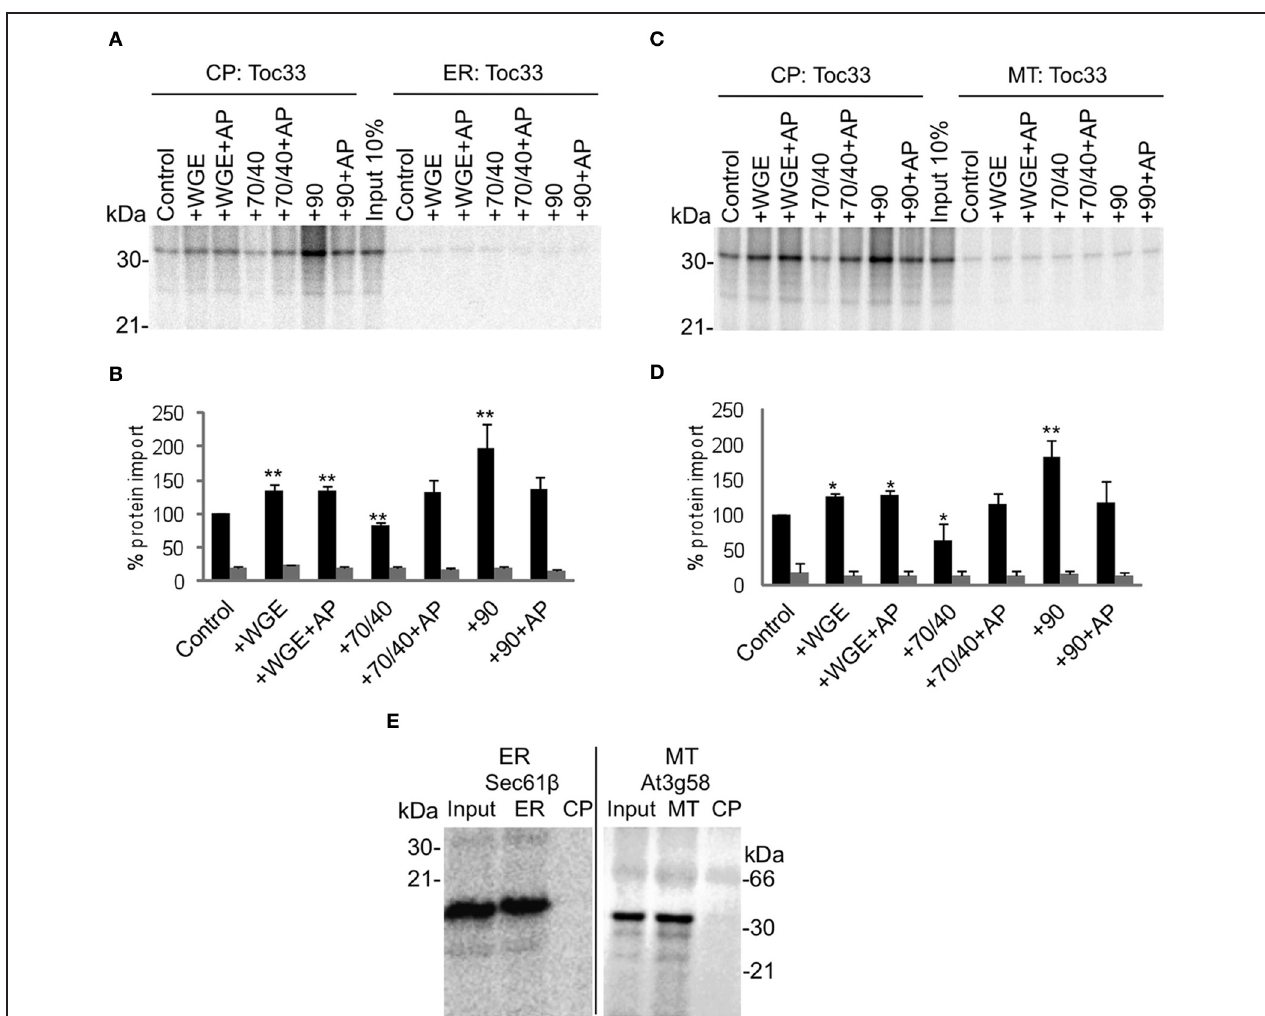
FIGURE 2 | Toc33 targets to chloroplasts efficiently and selectively under a wide range of cytosolic conditions. (A) Radio-labeled Toc33 protein derived from RNCs was incubated in a competitive targeting assay with chloroplasts (CP) and ER, with the addition of cytosolic components as indicated; control is buffer only, WGE is wheat germ extract, chaperones (Hsp) are indicated by their numbers (70/40 or 90), and AP represents apyrase treatment. Membranes were refractionated and washed with carbonate prior to analysis by SDS-PAGE. 10% of protein input is shown, and the protein molecular weight markers are indicated in kDa. (B) Quantification of protein import in part A. Mean and standard error are shown, normalized to